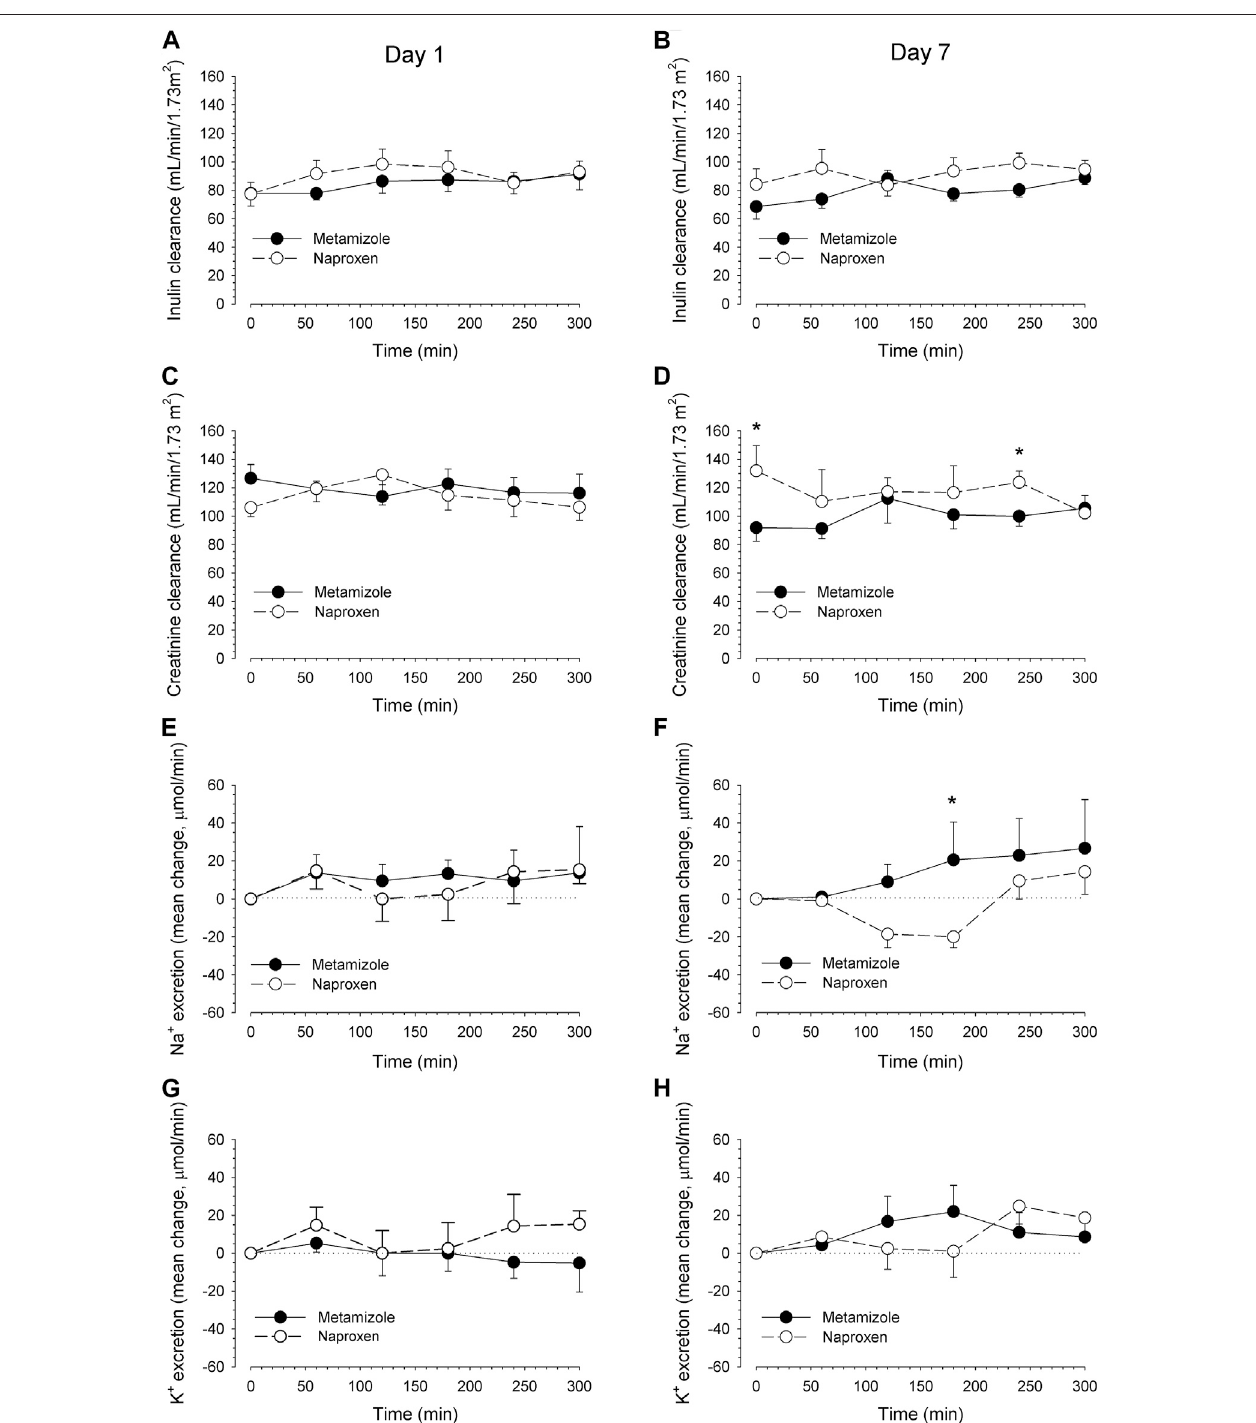
FIGURE3| Effectsonrenalinulinandcreatinineclearanceandsodiumandpotassiumexcretion.Therenalclearancesofinulin(re fl ectingGFR)andcreatinineaftera single oral dose of 1 g metamizole and 500 mg naproxen (day 1, left panels ) and after repetitive dosing at day 7 (right panels) are displayed in Figures 4A – D , respectively. Renal sodium excretion ( Figures 4E,F ) and potassium excretion ( Figures 4G,H ) as the difference to baseline excretion (time interval 08:00 to 09:00). The basalsodium excretion (mean ± SEM) was 40 ± 9 µmol/min and the basal potassium excretion 53 ± 12 µmol/min. Data are presented asmean values ± SEM. * p < 0.05 naproxen vs metamizole of the same time interval. There were no signi fi cant differences with baseline values within the different treatment groups.